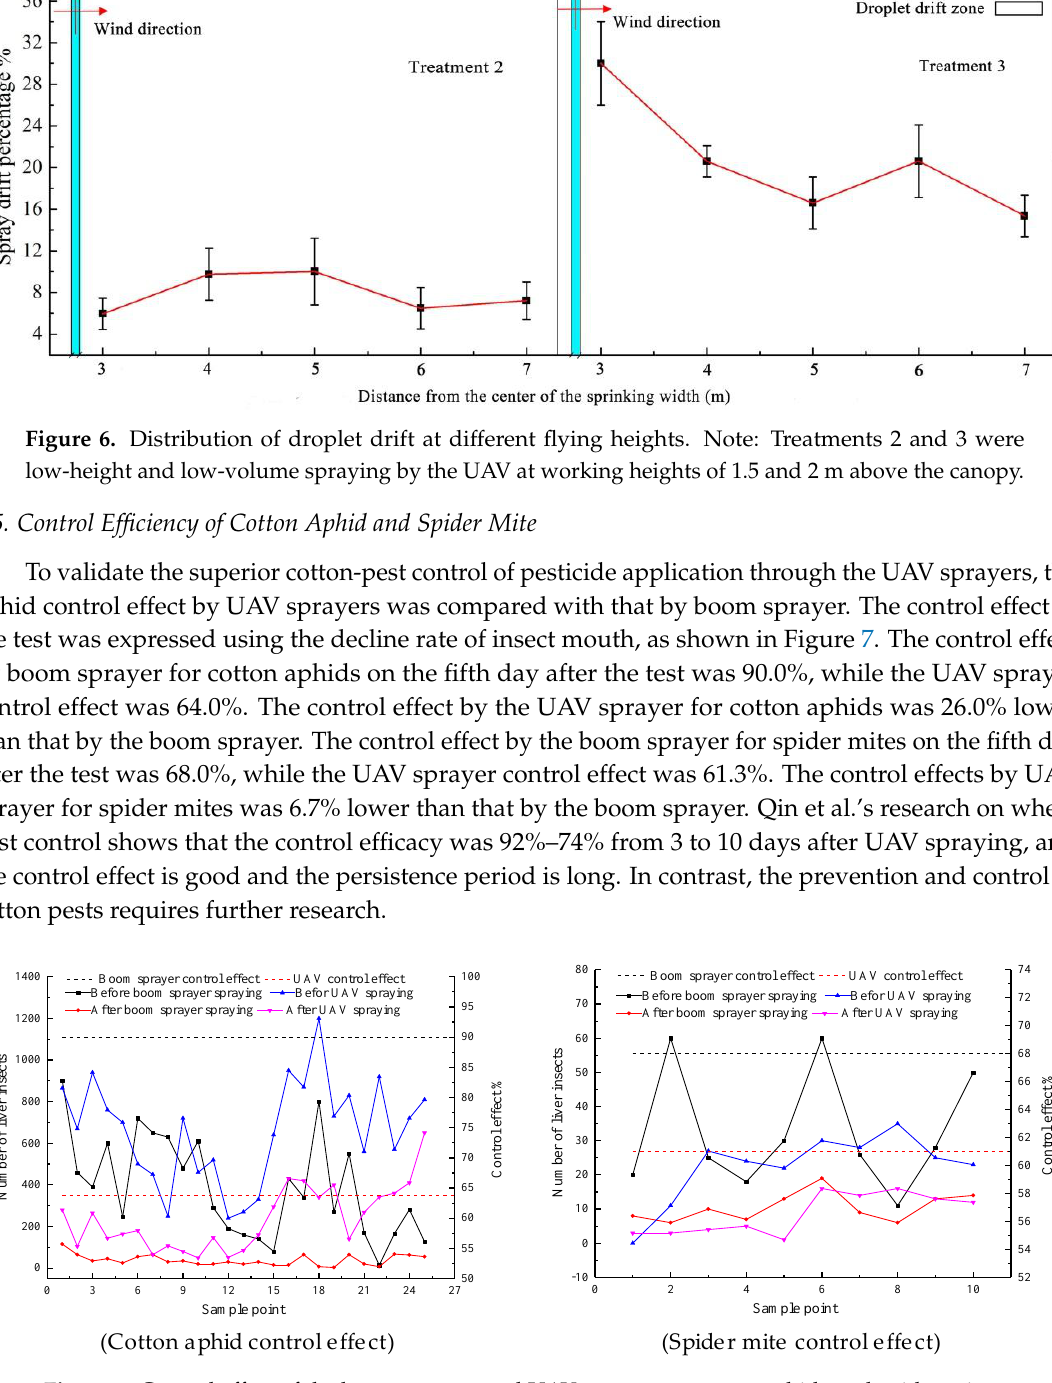
Figure 7. Control effect of the boom sprayer and UAV sprayer on cotton aphids and spider mites.